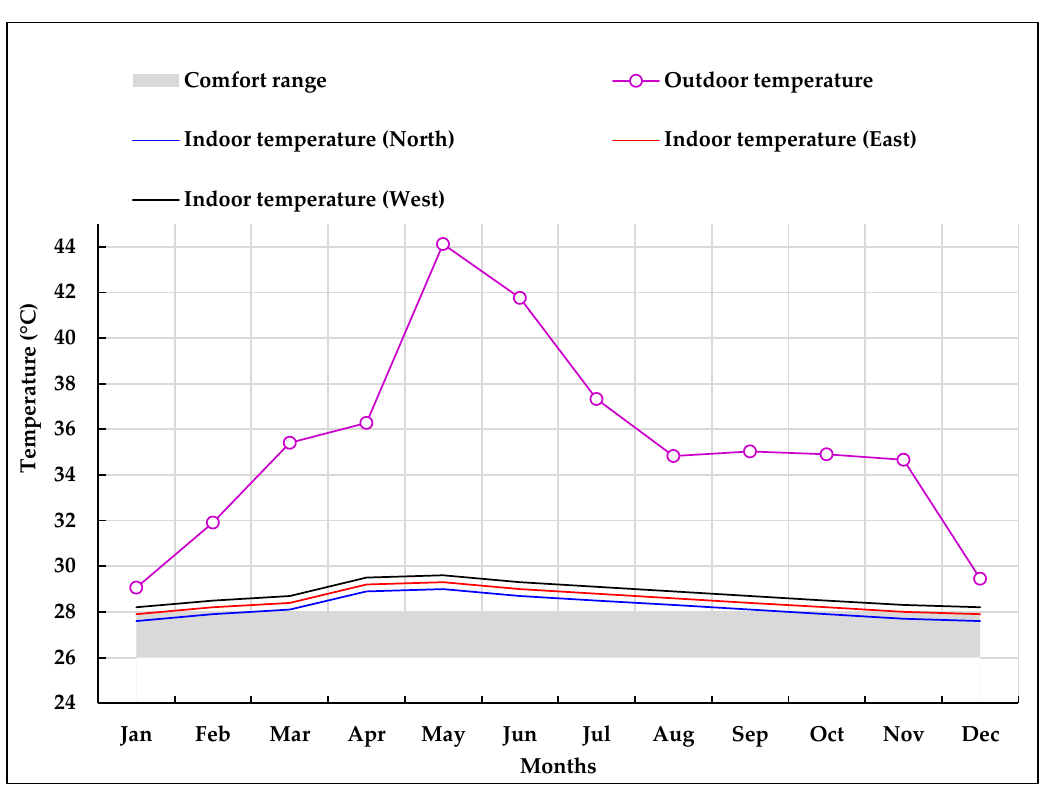
Figure 7. The average monthly indoor temperatures in the ACB in EAHEs 1 (west), 2 (north), and 3 (east) under case 3.